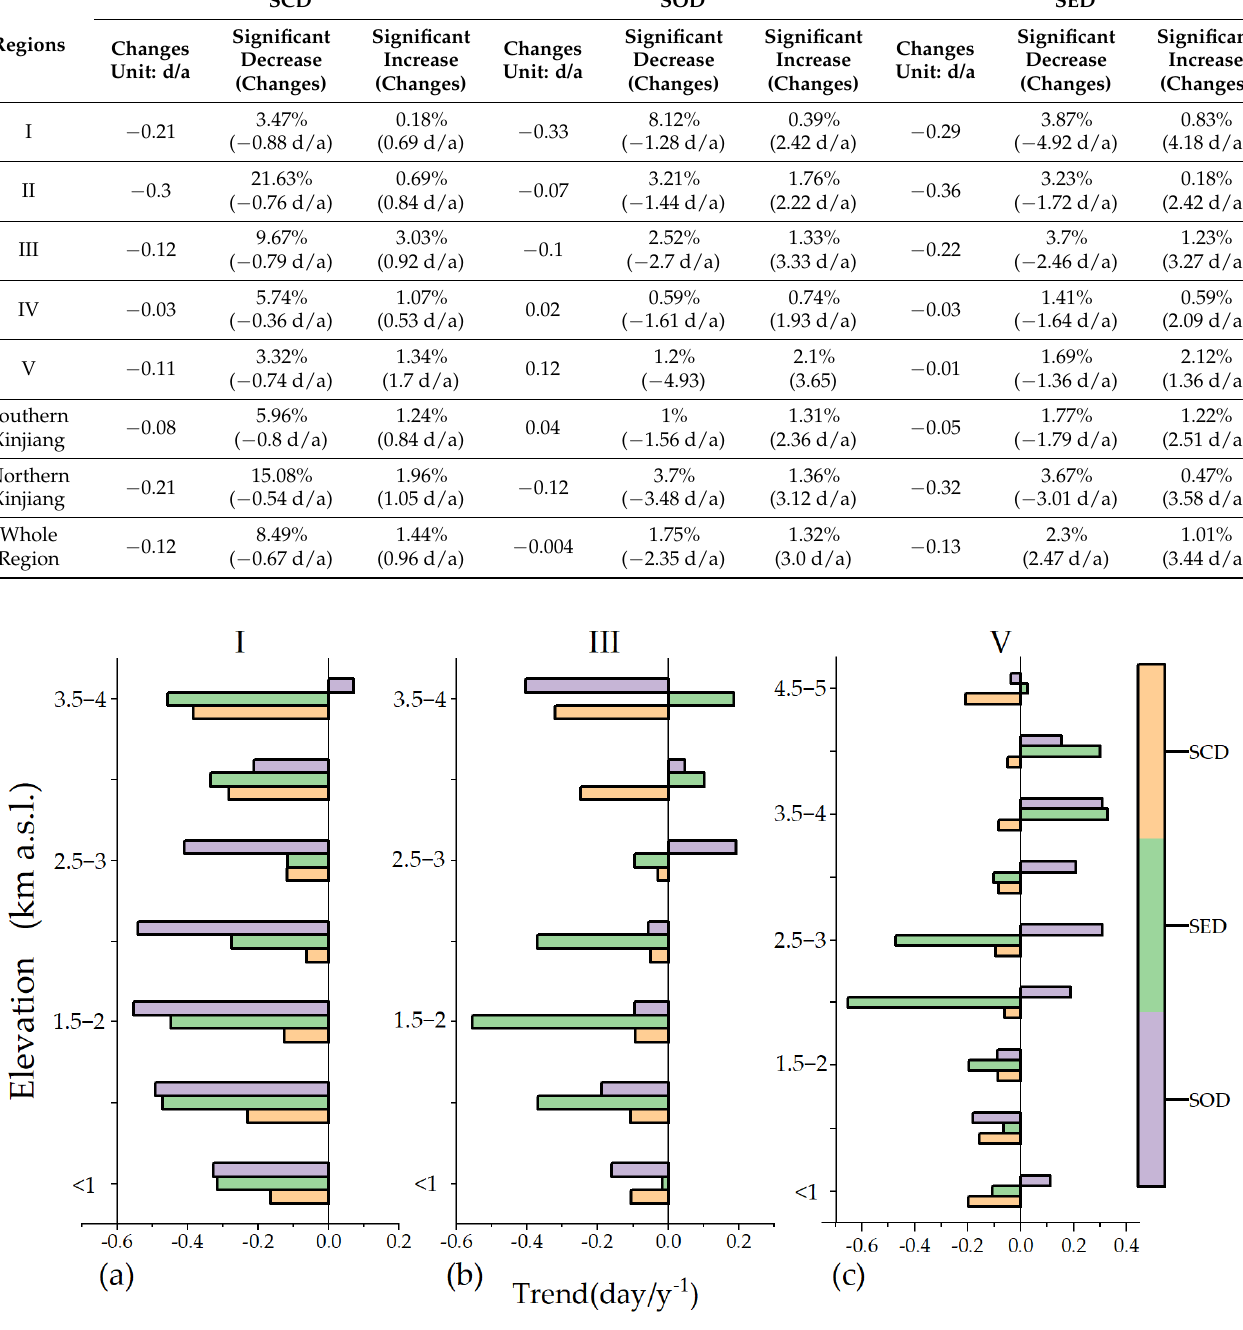
Figure 10. Depiction of trend of duration of snow cover phenology with elevation during 2001–2020: ( a ) Altai Mountains; ( b ) Tienshan Mountains; ( c ) Kunlun Mountains.